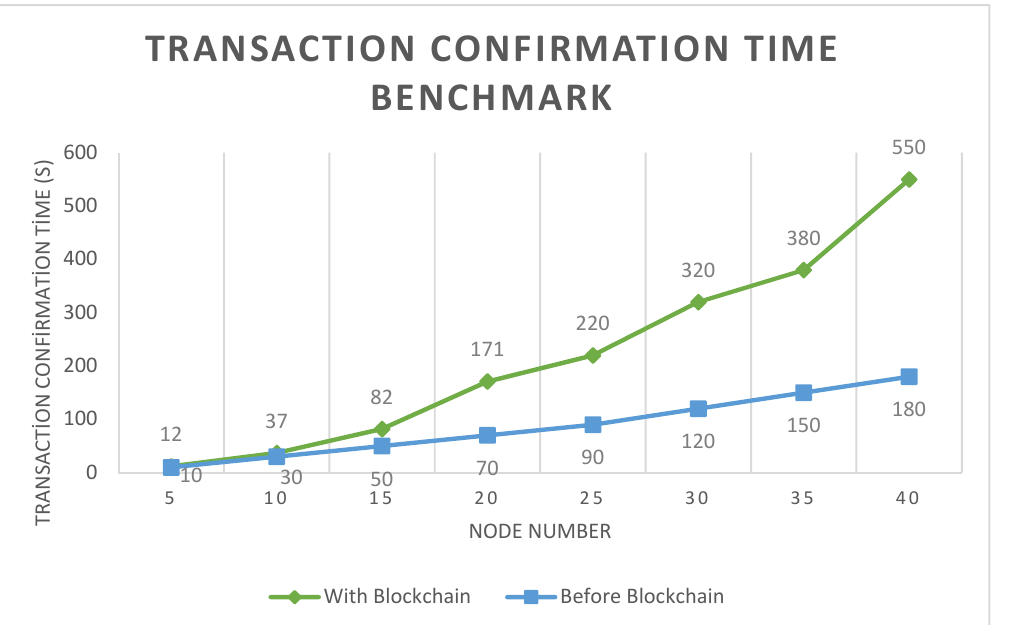
Figure 17. Benchmark of transaction confirmation time (with and without blockchain layer). Secondly, the throughput value comparisons are performed. It is seen that the throughput increases proportionally before the blockchain layer is added. After adding the blockchain layer, it is observed that the efficiency is higher even before the blockchain in the low transaction and node numbers, but as the number of transactions and nodes increases, the acceleration gradually decreases and starts to become stable (Figure 18).